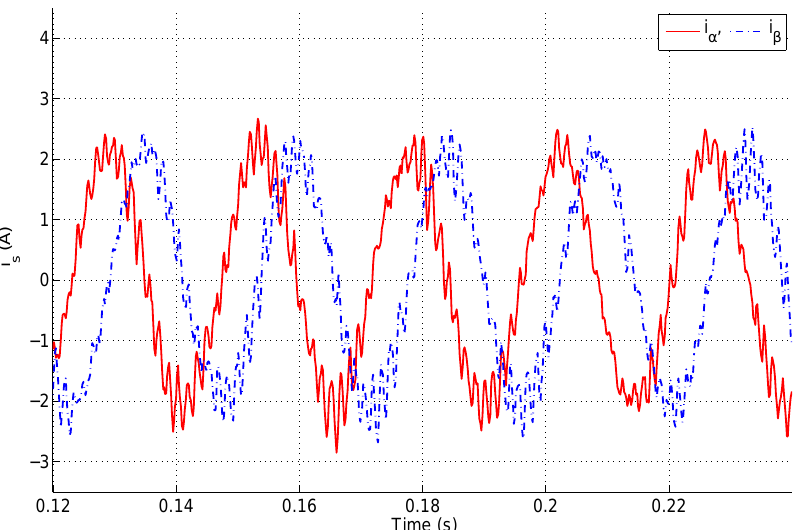
Figure 3. Example of trajectories gathered in the experimental setup for model